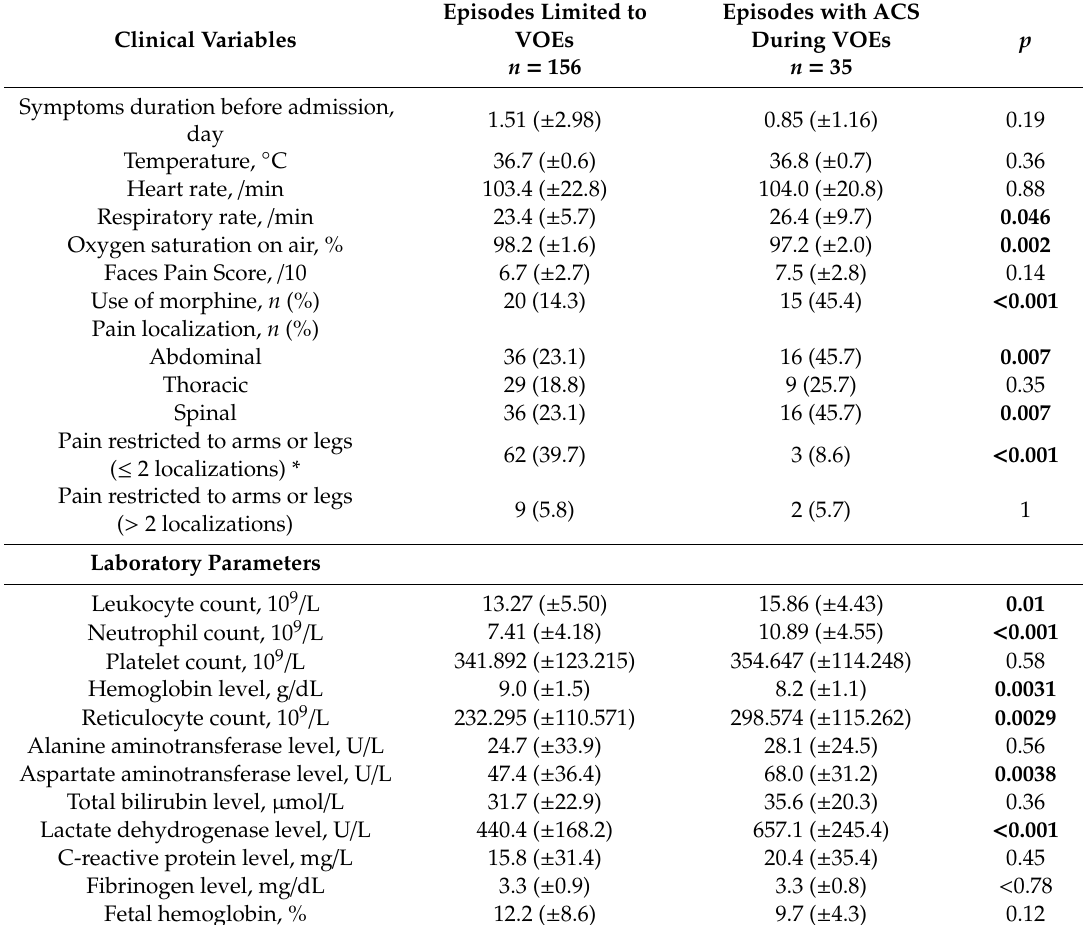
Table 2. Clinical and laboratory parameters at admission (day 0) by development or not of ACS during VOEs in children with sickle cell